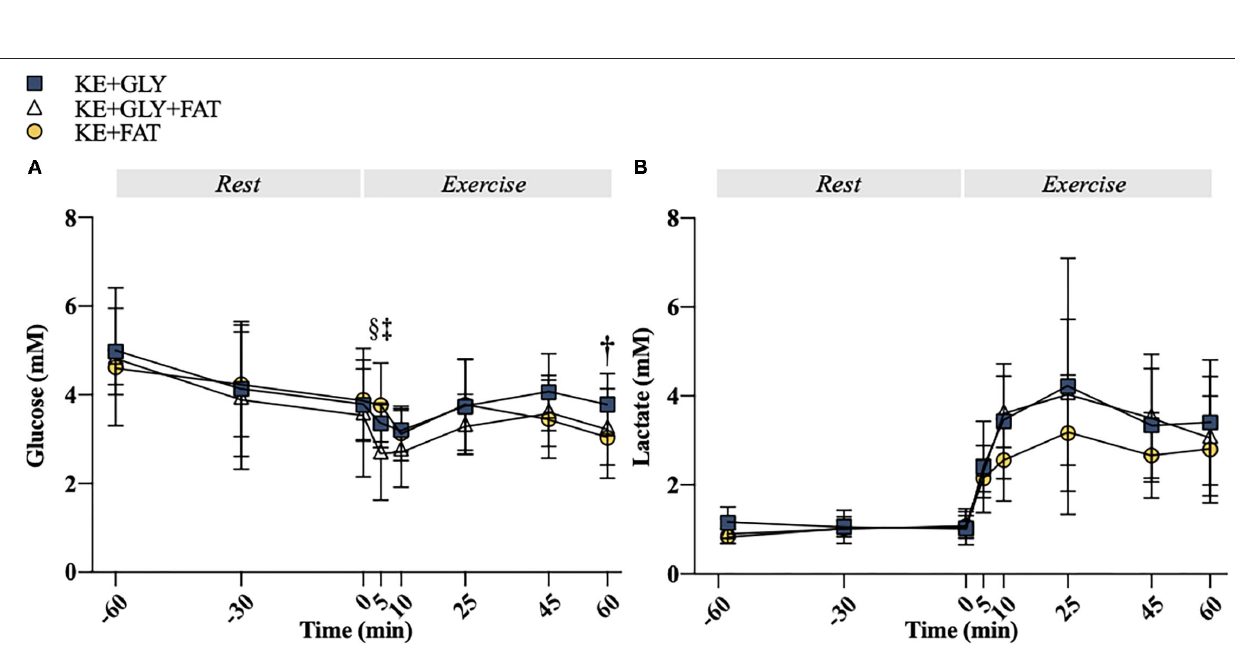
Frontiers in Medicine |